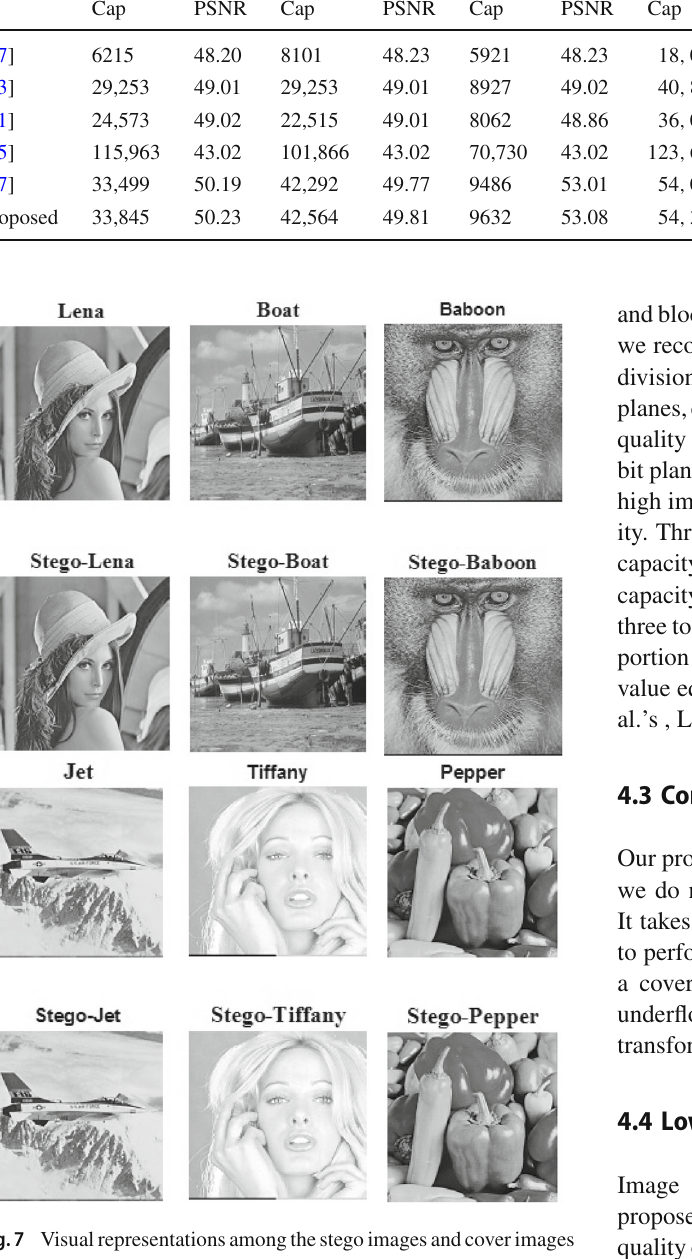
sequently, CDMBP controls the growth proportion of extra bits by expanding more EC besides maintaining high PSNR